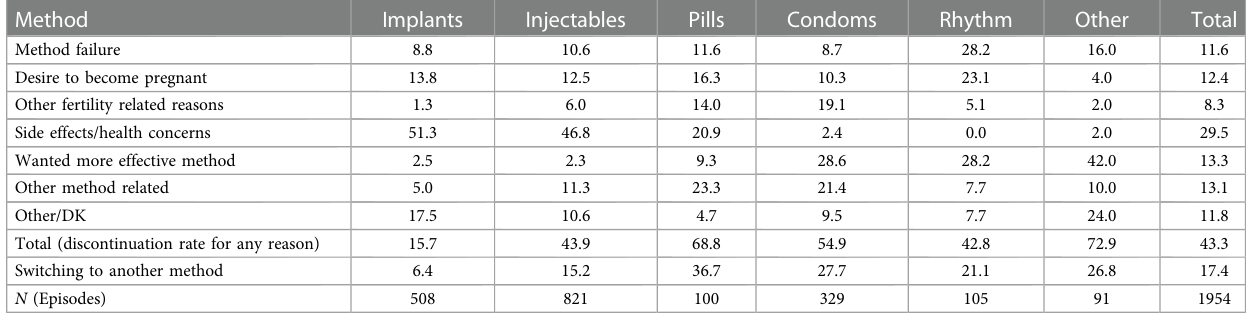
TABLE 2 Percent distribution of discontinuations of contraceptive methods in the 12 months preceding the survey by main reason stated for discontinuation, according to speci fi c method, Homa Bay, Kenya 2017.